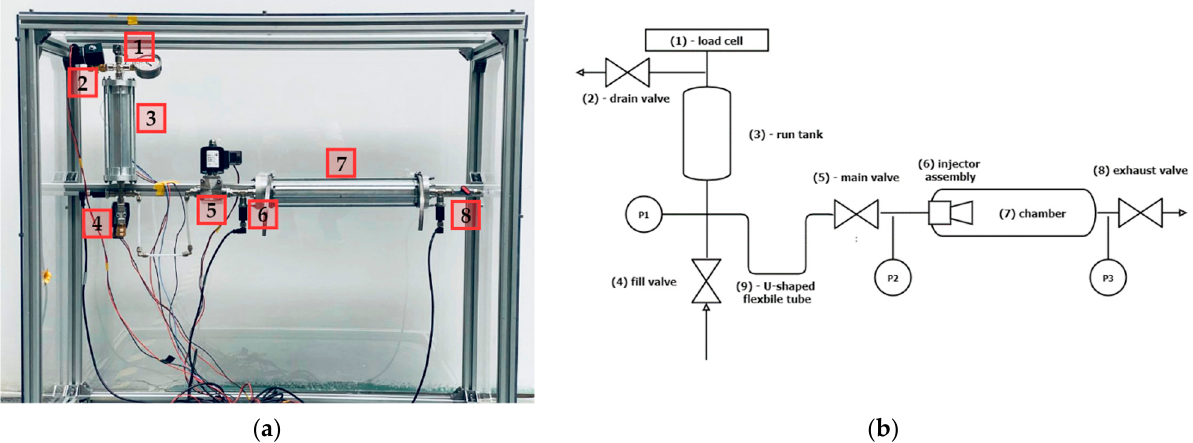
Figure 1. ( a )—Photo of the test stand, ( b )—Schematic diagram of the test stand. 1—load cell, 2—drain valve, 3—run tank, 4—fill valve, 5—main valve, 6—injector assembly, 7—chamber, 8—exhaust valve, and 9—U-shaped flexible tube. The storage tank and fill tube are not shown.